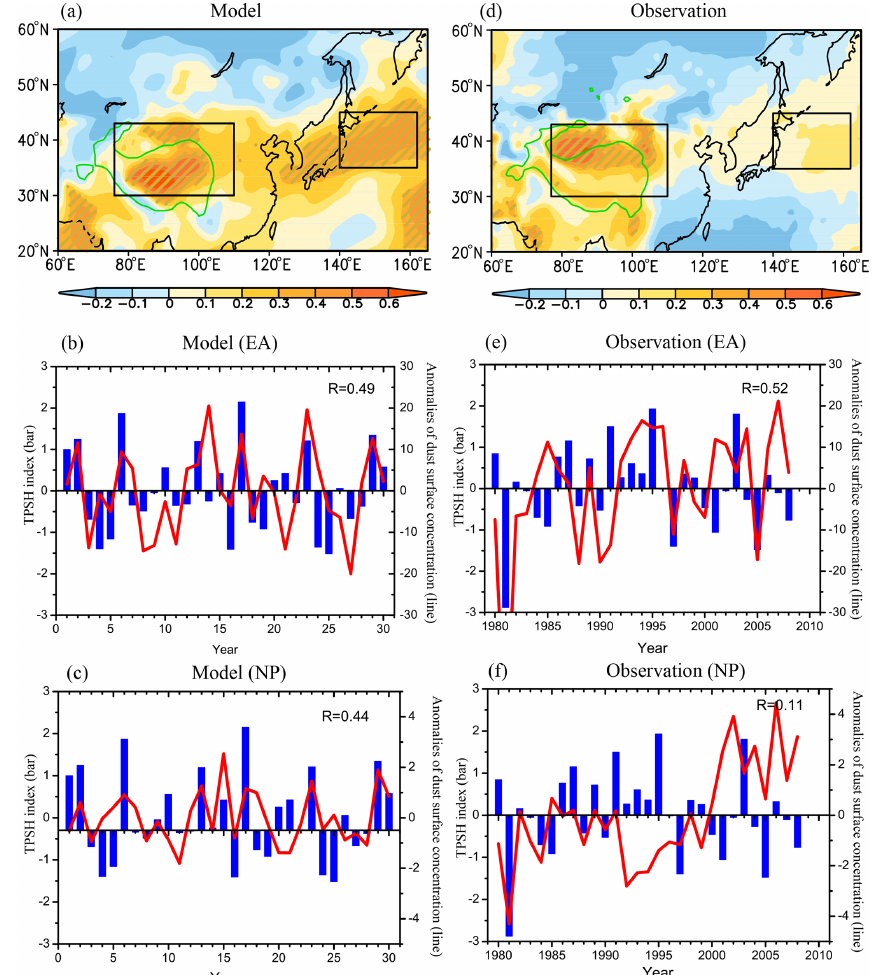
Figure 3. (a) Spatial distribution of the correlation coefficients between the index of sensible heat over the TP (TPSH index) and the anomalies of surface dust concentration in MAM for the 30-year CAM4-BAM simulation. (b) The observed TPSH index (Duan et al., 2017) and the anomalies of MERRA-2 surface dust concentration for the years 1980–2008, and the corresponding time series of regionally averaged surface dust concentration (red line) over the East Asian dust source area ( b for the model and e for observations) and over northwestern Pacific ( c for model and f for observations) and the TPSH index (blue bars). Here, the slanted grey lines (a, d) represent the grid points where the changes pass the two-tailed t test at the 5% significance level, and the green-contour area indicates the plateau above